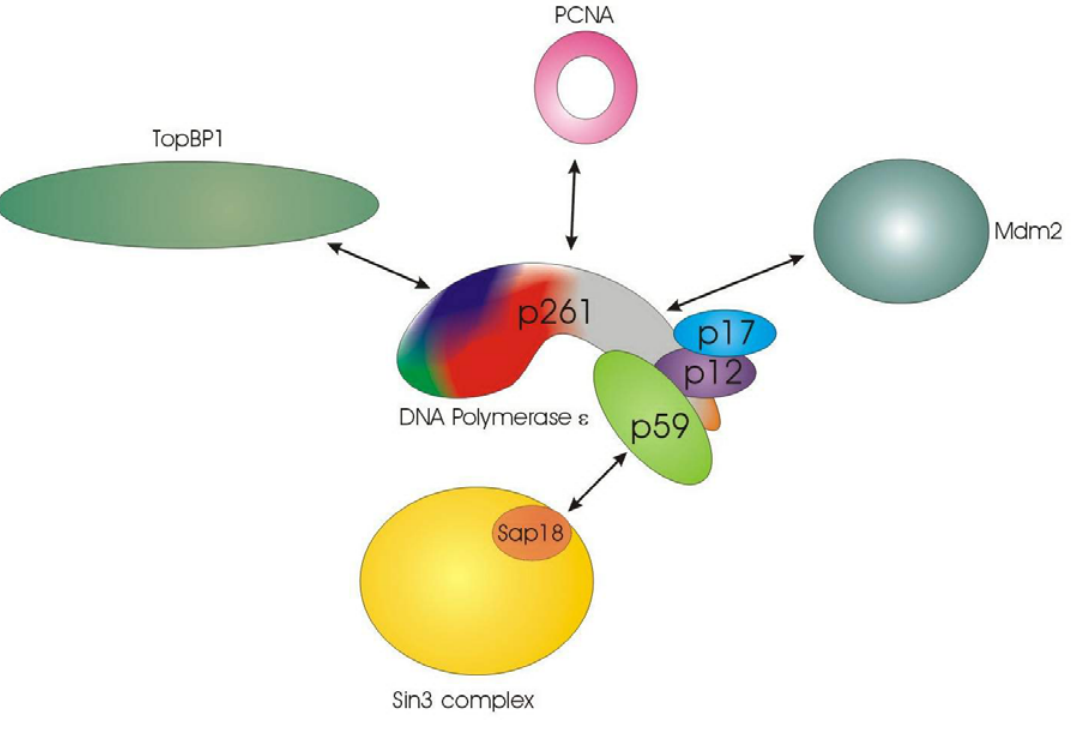
FIGURE 1 . Subunit structure of human Pol ε , and the reported interactions with other proteins. The aminoterminal, exonuclease, and polymerase domains, and the carboxyterminal zinc fingers of the catalytic subunit are indicated schematically in green, blue, red, and orange, respectively.